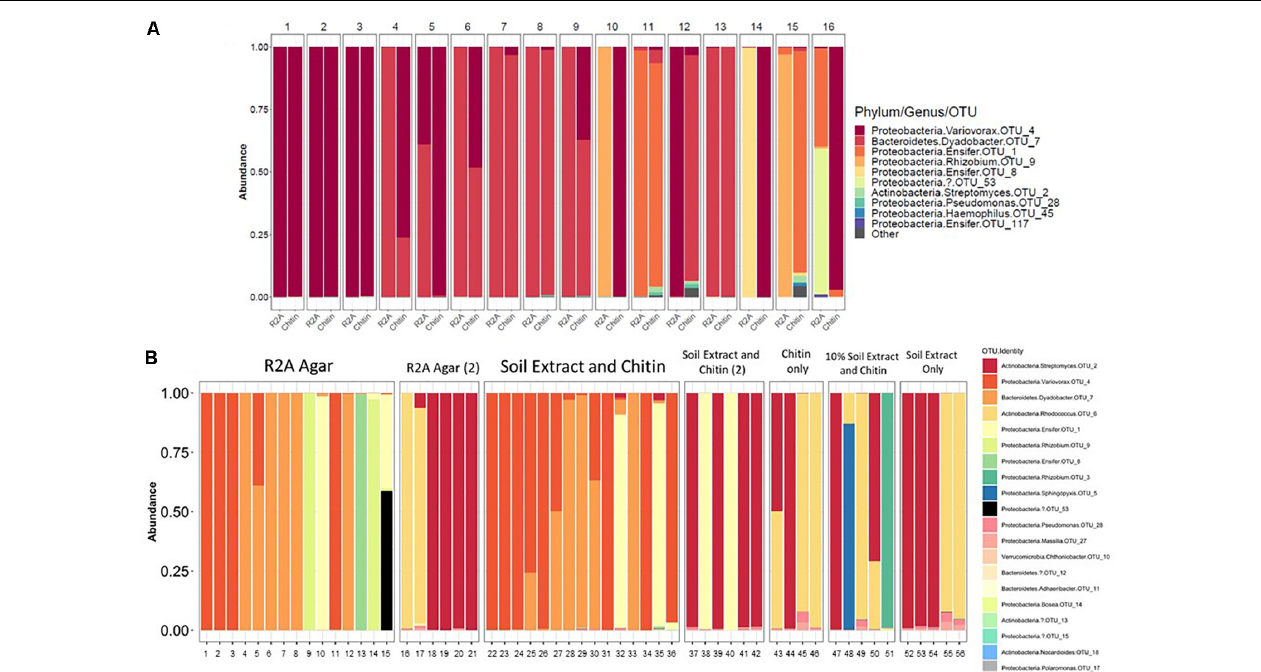
FIGURE 6 | Isolation of microbial constituents of Model Soil Consortium MSC-1. (A) MCS-1 isolates were obtained either on chitin/soil extract plates, indicated by “Chitin” or R2A agar plates, indicated by “R2A.” After 16S amplicon sequencing analysis, read counts were rarified to 2278 and the number of counts aligning to different phyla for each colony is shown. (B) Similar to (A) but a second round of isolation using additional media sources, colonies are not numbered, each column indicates an individual colony subjected to 16S amplicon sequencing analysis. Multiple rounds [indicated by a (2)] were performed for R2A agar and for chitin/soil extract